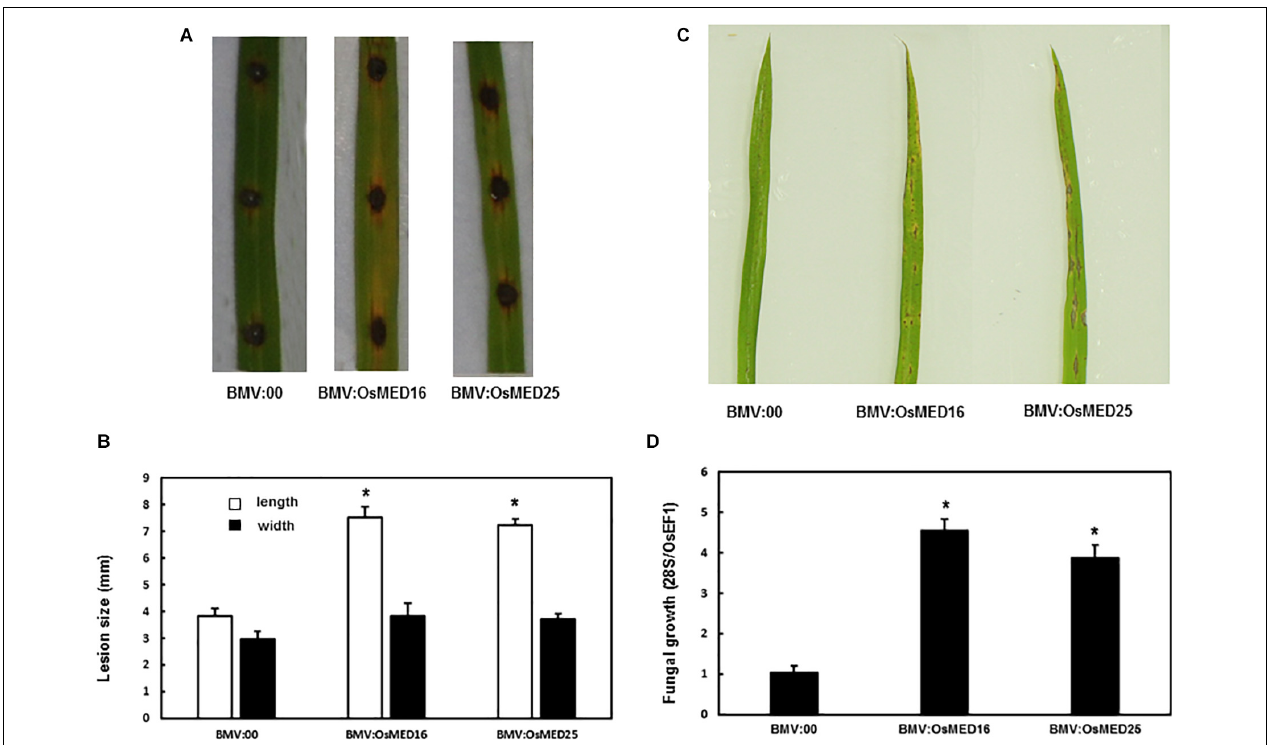
FIGURE 6 | BMV:OsMED16- and BMV:OsMED25-infiltrated plants displayed reduced resistance to Magnaporthe grisea when compared with BMV:00-infiltrated plants. (A) The phenotype of BMV: OsMED16-, BMV: OsMED25-, and BMV:00-infiltrated plants following M. grisea inoculation by detached leaf analysis. (B) The lesion size was measured using the detached leaf analysis. (C) The phenotype of BMV: OsMED16-, BMV: OsMED25-, and BMV:00-infiltrated plants following M. grisea inoculation by whole plant analysis. (D) Fungal growth in BMV: OsMED16-, BMV: OsMED25-, and BMV:00-infiltrated plants following M. grisea inoculation. *Above the columns indicate significant differences at p < 0.05 between the silencing plants and the